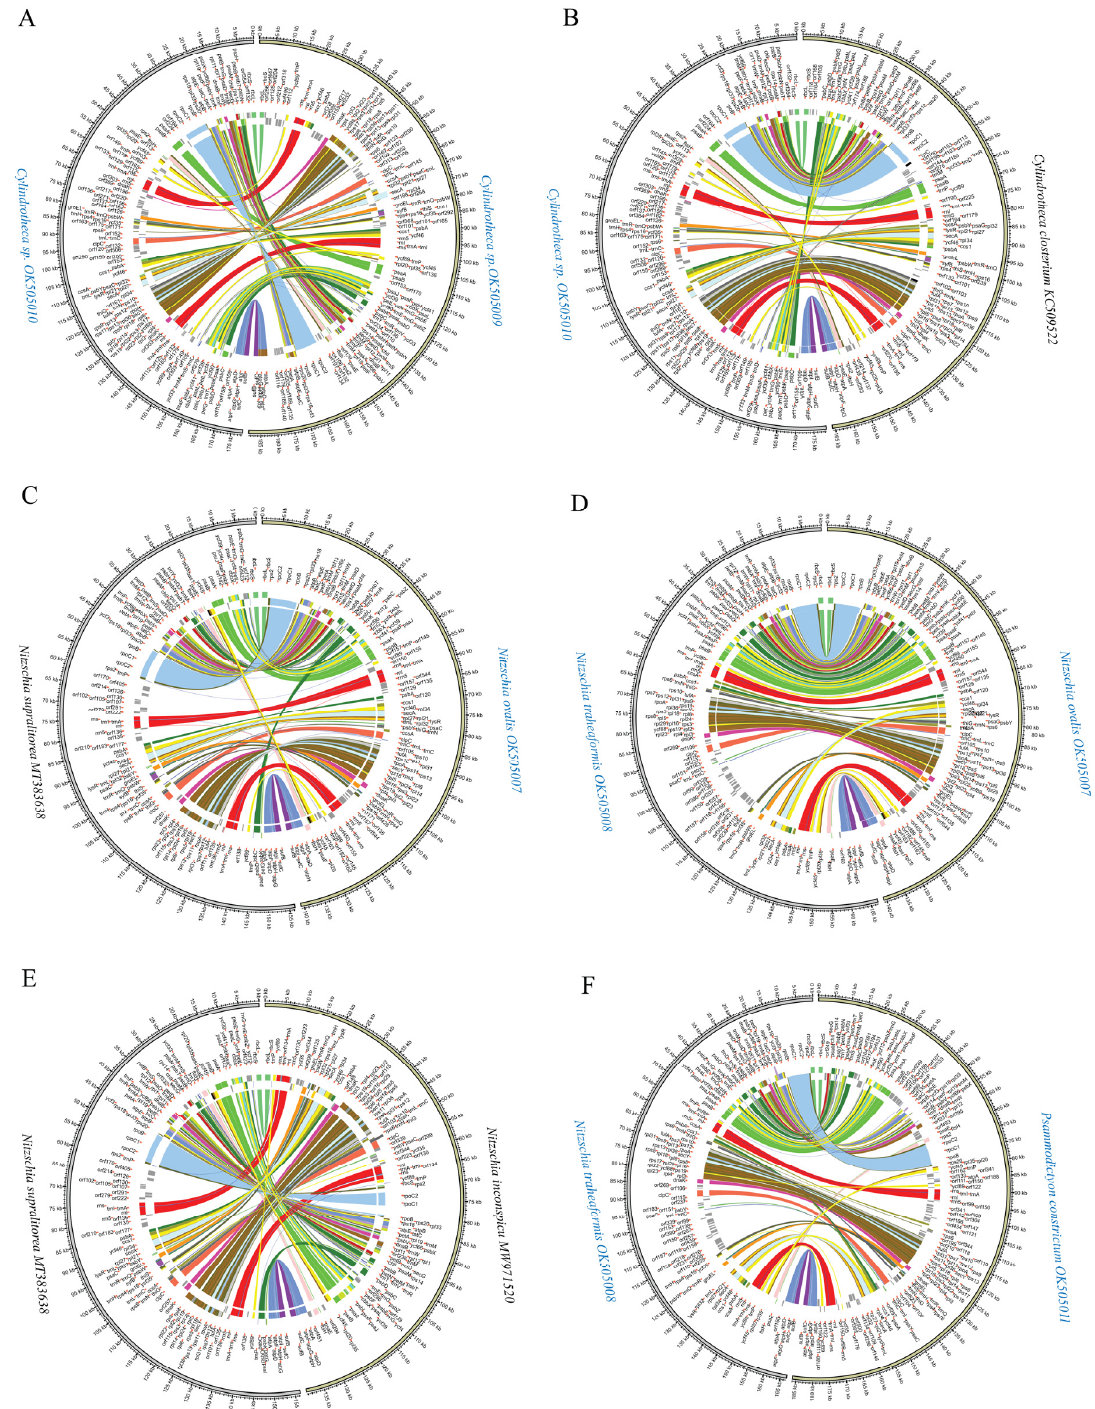
Figure 7. Pair-wise comparison of representative Bacillariales cpDNAs. ( A ) The comparative analysis of Cylindrotheca sp . OK505009 and Cylindrotheca sp . OK505010 cpDNAs. ( B ) The comparative analysis of Cylindrotheca closterium KC509522 and Cylindrotheca sp. OK505010 cpDNAs. ( C ) The comparative analysis of Nitzschia ovalis OK505007 and Nitzschia supralitorea MT383638 cpDNAs. ( D ) The comparative analysis of Nitzschia ovalis OK505007 and Nitzschia traheaformis OK505008 cpDNAs. ( E ) The comparative analysis of Nitzschia inconspicu MW971520 and Nitzschia supralitorea MT383638 cpDNAs. ( F ) The comparative analysis of Psammodictyon constrictum OK505011 and Nitzschia traheaformis OK505008 cpDNAs. The assignment of genes into different functional groups is indicated by colors.